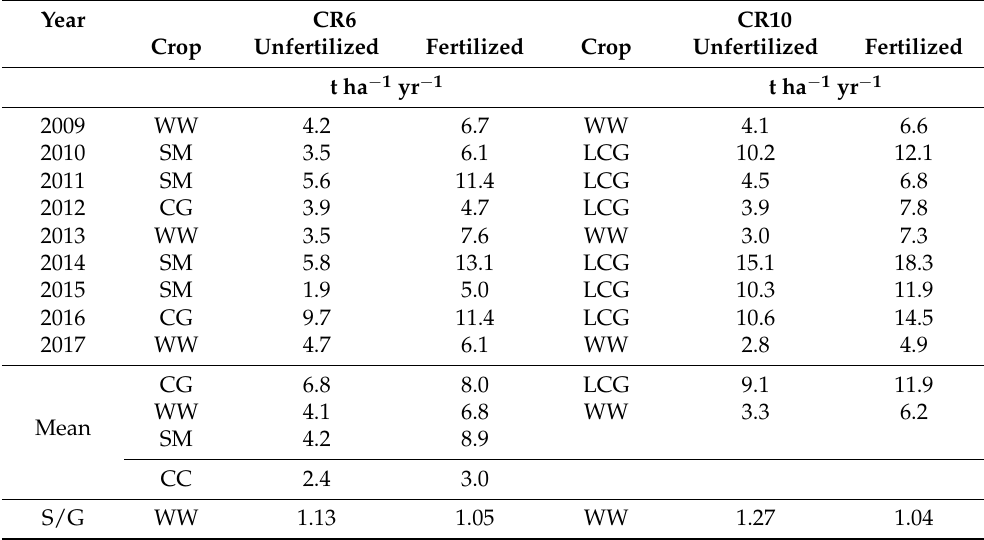
Table 3. Mean annual dry matter yields of crop rotations CR6 and CR10 in unfertilized plots and plots fertilized with biogas digestate (n = 4). WW: winter wheat (grain only), SM: silage maize, CG: clover-grass mixture, LCG: lucerne-clover-grass mixture, CC: cover crop (not harvested), and S/G: straw/grain ratio. Year CR6 CR10 Crop Unfertilized Fertilized